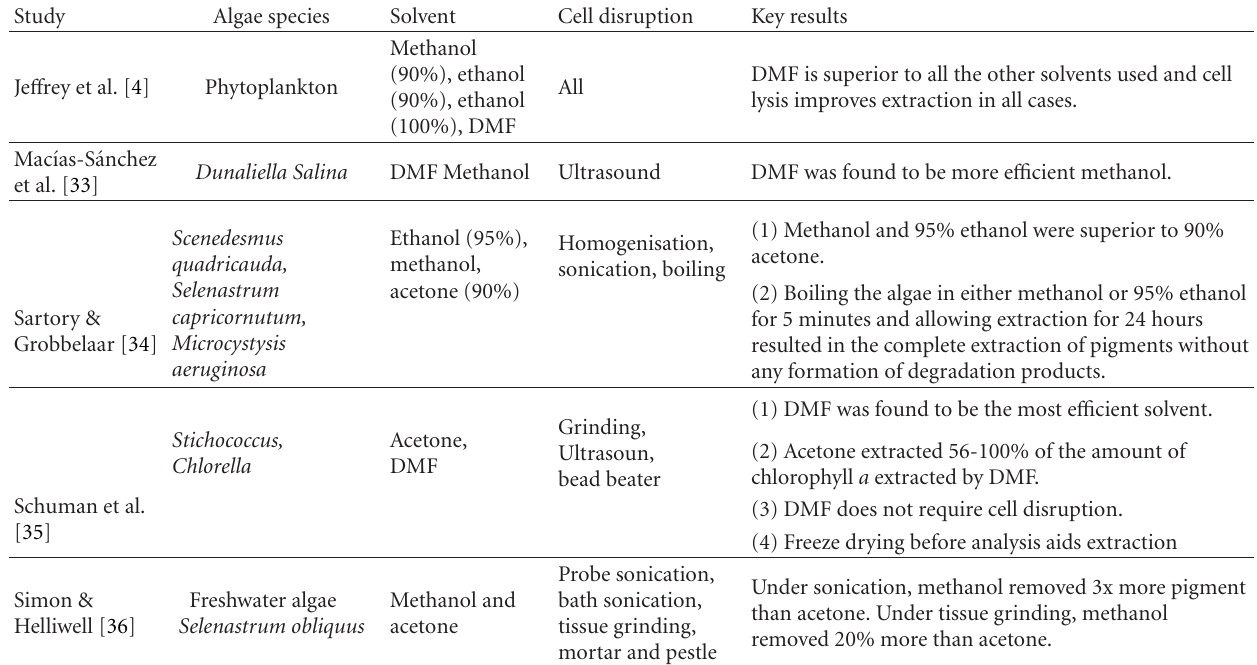
Table 1: Previous studies on organic solvent extraction of microalgal